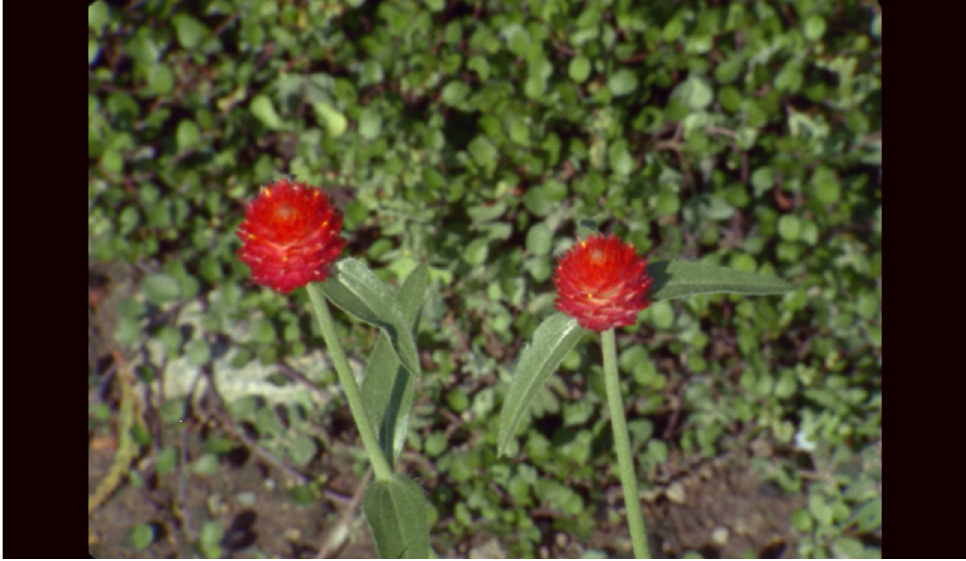
Fig. 3 – Still from Atomic Garden (2018). Courtesy of the